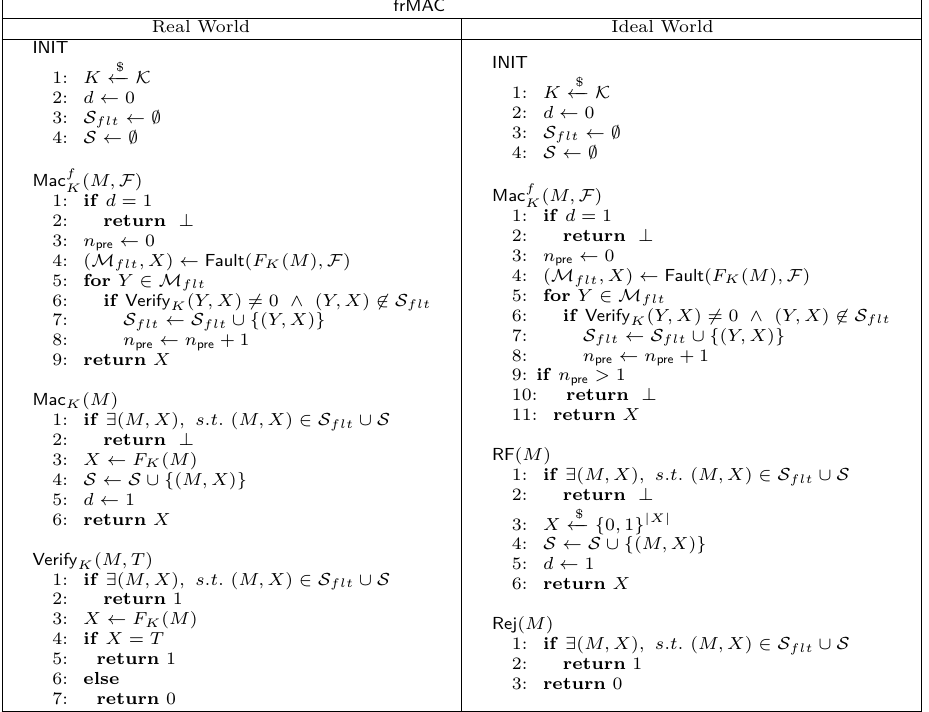
Table 6: The frMAC Oracles frMAC Real World Ideal World INIT